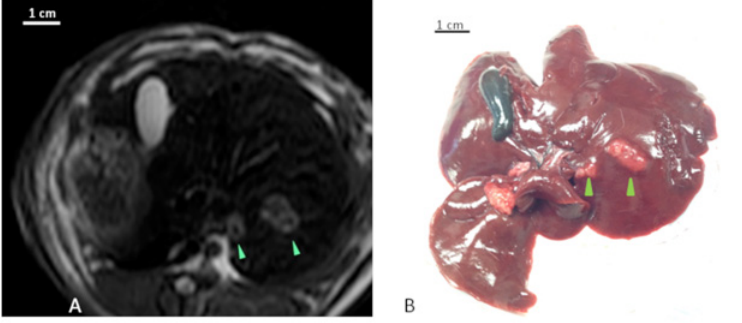
Fig 3. MRI and Gross Pathology. (A) Axial T2 weighted MRI image demonstrates two T2 hyperintense lesions in the left hepatic lobe (arrow heads). (B) Explanted gross specimen reveals tumors corresponding to the lesions seen on MRI (arrow